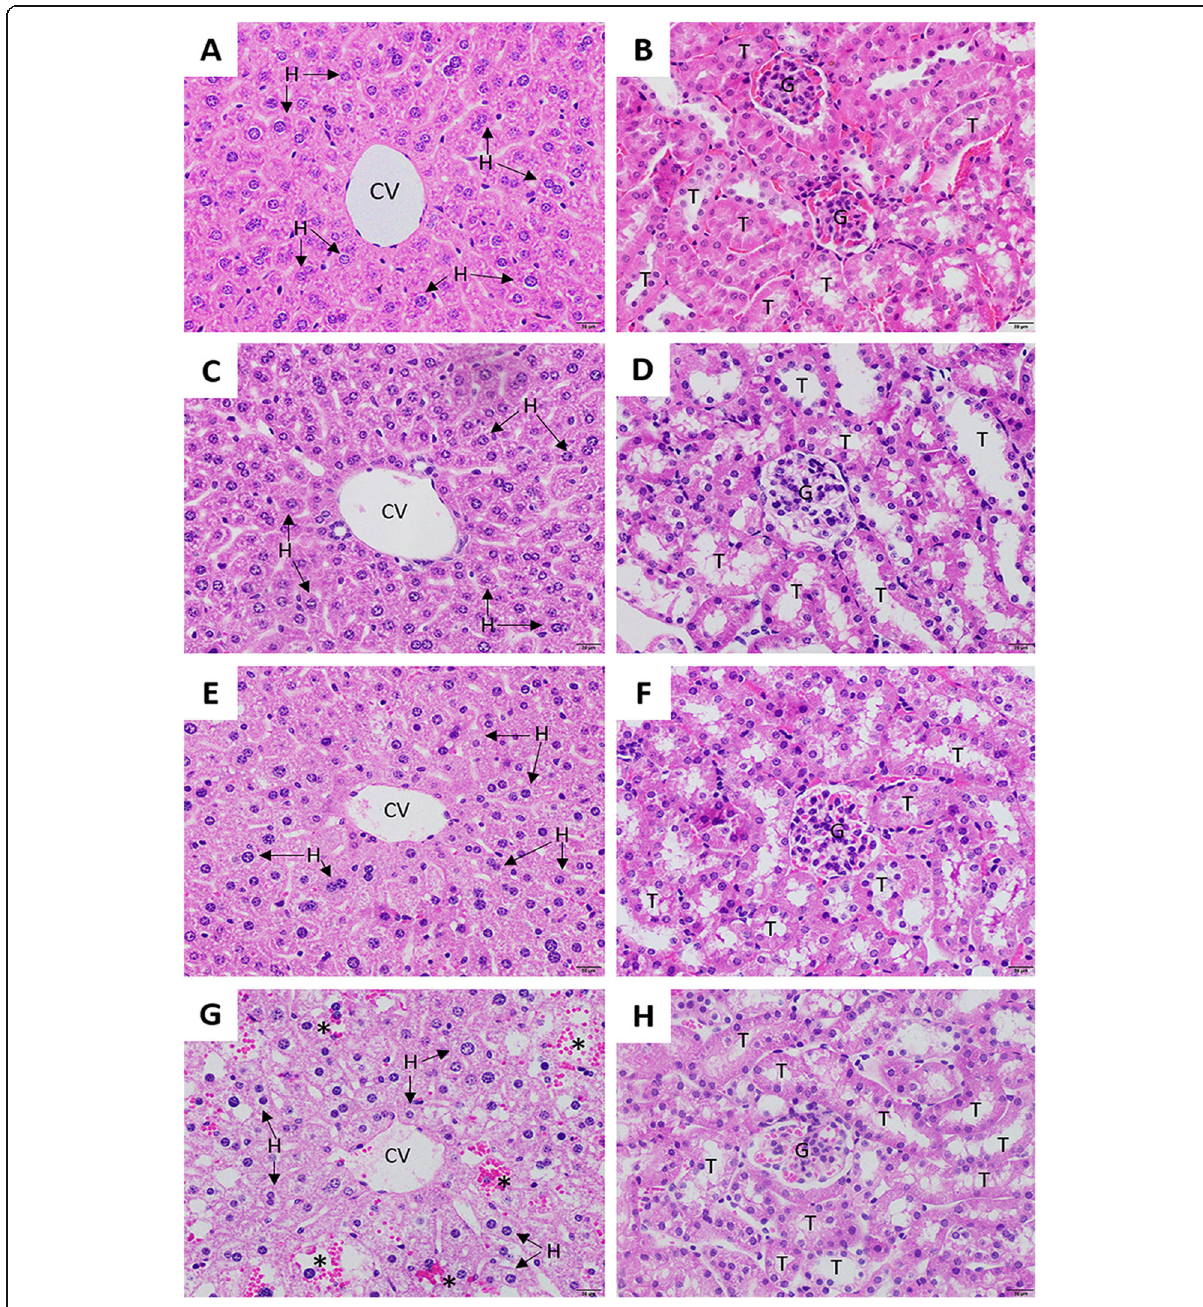
Fig. 1 Histopathology of the liver and kidney of mice during the acute toxicity test of the untreated group ( a and b ), the negative control group ( c and d ), the group treated with 2000 mg/kg aqueous S. exigua root extract ( e and f ) and the group treated with 2000 mg/kg ethanolic S. exigua root extract ( g and h ). H hepatocyte, CV central vein, S sinusoidal capillary, G glomerulus, T tubule. The asterisk shows the area of hepatic